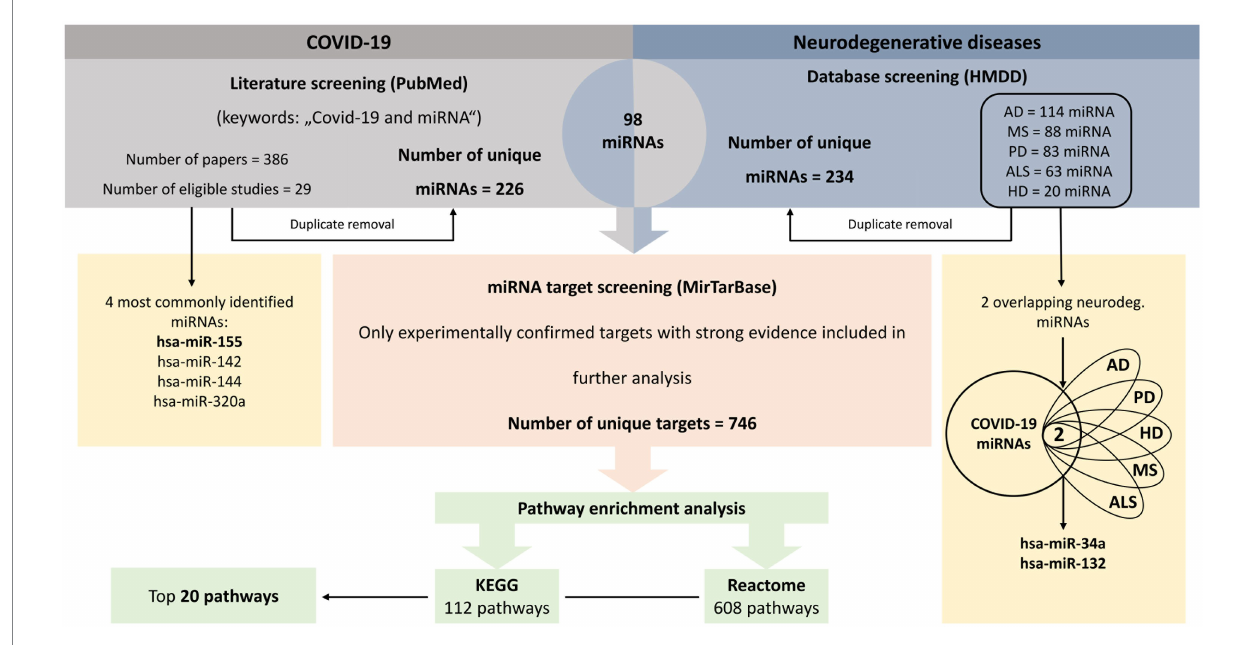
FIGURE 1 Workflow of the analysis. Integration of literature and database screening to identify miRNAs associated with neurodegenerative diseases and COVID-19, their target genes and pathway enrichment analysis. AD, Alzheimer’s disease; ALS, amyotrophic lateral sclerosis; COVID-19, coronavirus disease 2019; HD, Huntington’s disease; HMDD, Human microRNA Disease Database; MS, multiple sclerosis; PD, Parkinson’s